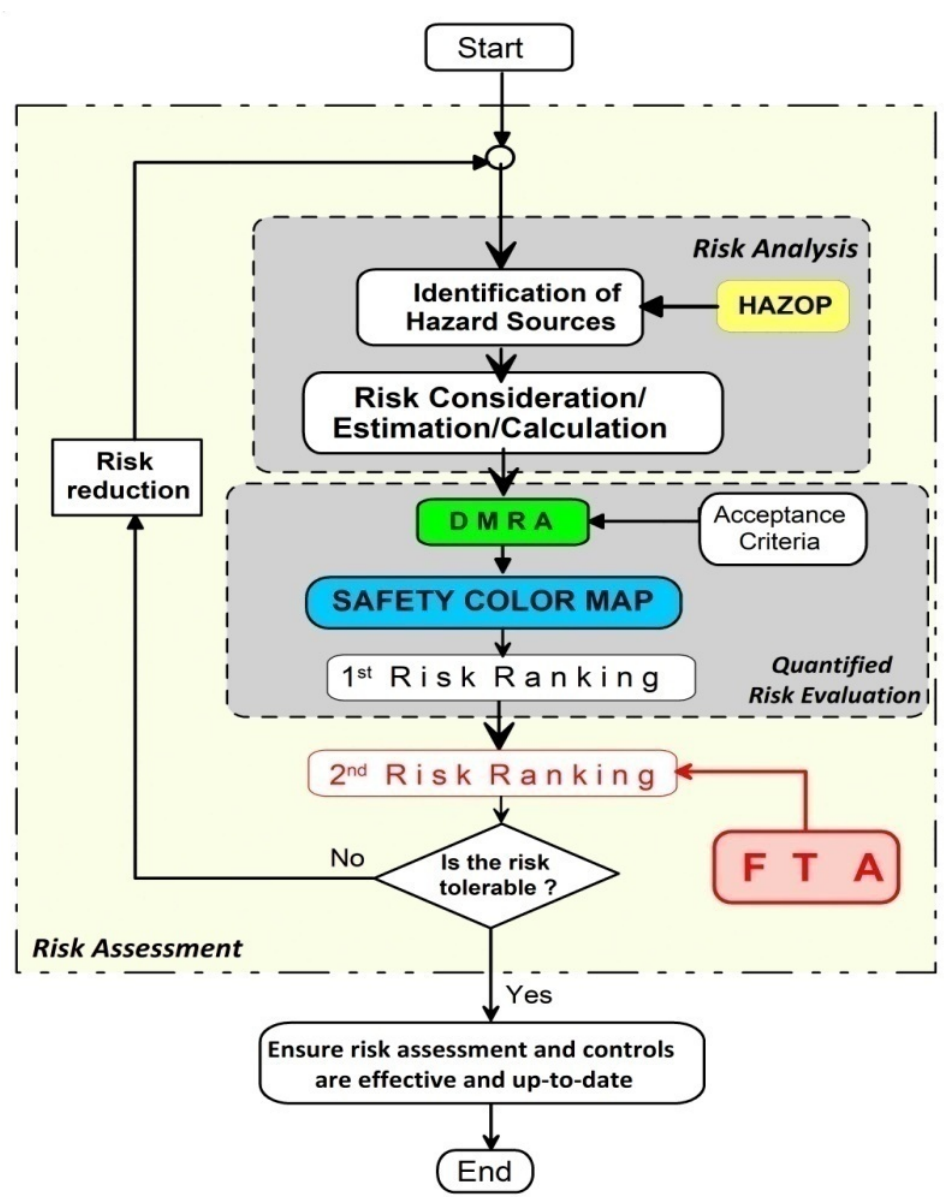
Figure 9. A renewal of the initially suggested collaborative framework by